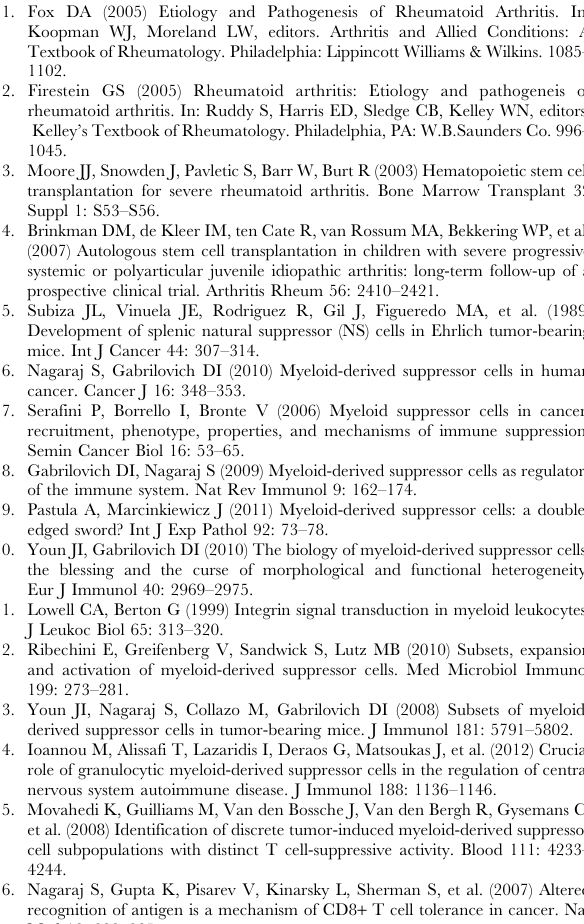
Table S1 Concentrations of GM-CSF, IL-6, and G-CSF in synovial fluid (SF) and serum collected from arthritic (PGIA)